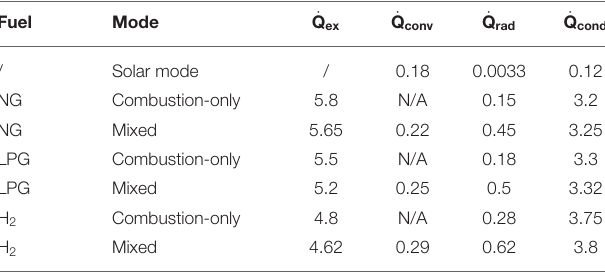
TABLE 3 | Measured values of the heat losses for the different modes of operation and fuel analyzed, conditions for combustion operations: P in = 12 kW, φ = 0.9, Q HTF = 150 slpm.